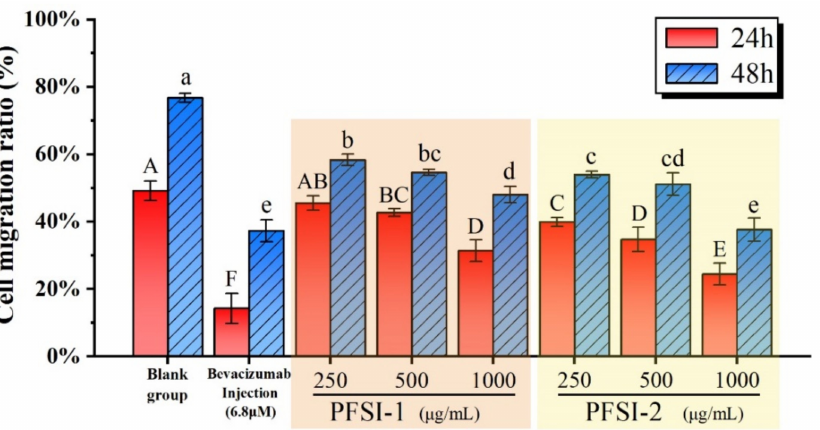
Figure 11. Migration ability of PFSI-1 and PFSI-2 on SMMC 7721 cells. (Note: the same small (capital) letters indicate no significant difference between groups, and different small (capital) letters indicate a significant difference between groups, p <